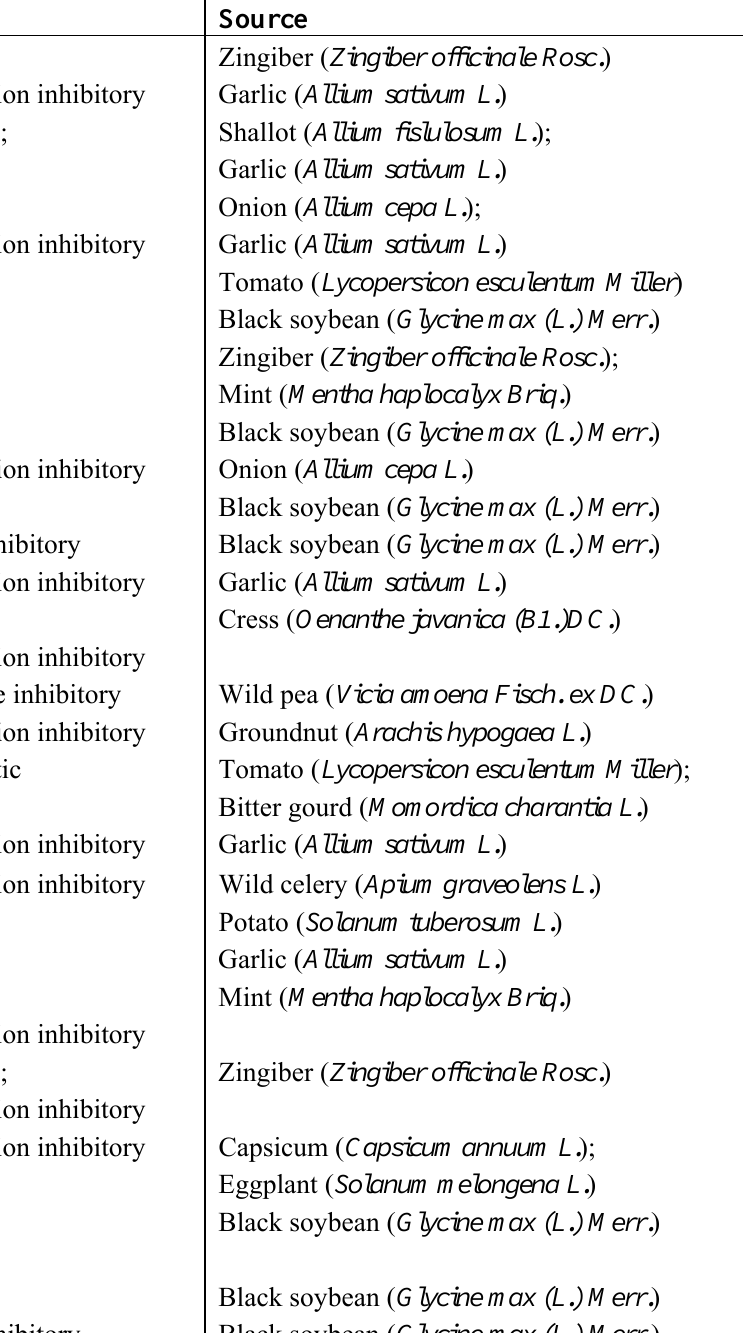
Table 1 . TCMD-documented vegetable and legume functional components associated with ameliorating type 2